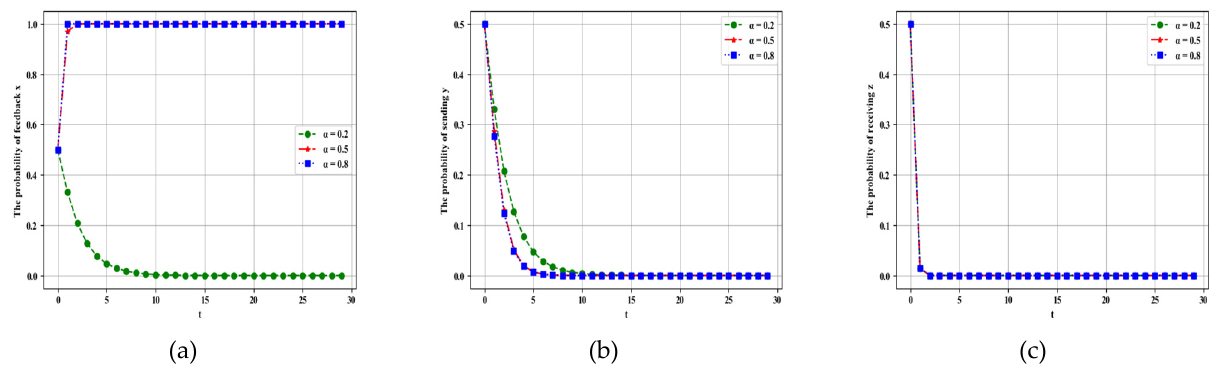
Figure 11. Evolutionary results of α shown under different probabilities of strategies x , y , and z in ( a ), ( b ), and ( c ), respectively.